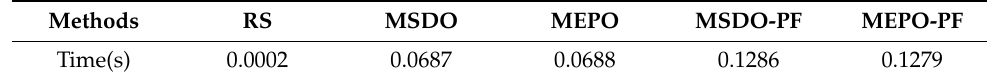
Table 8. Comparison of the positioning simulation